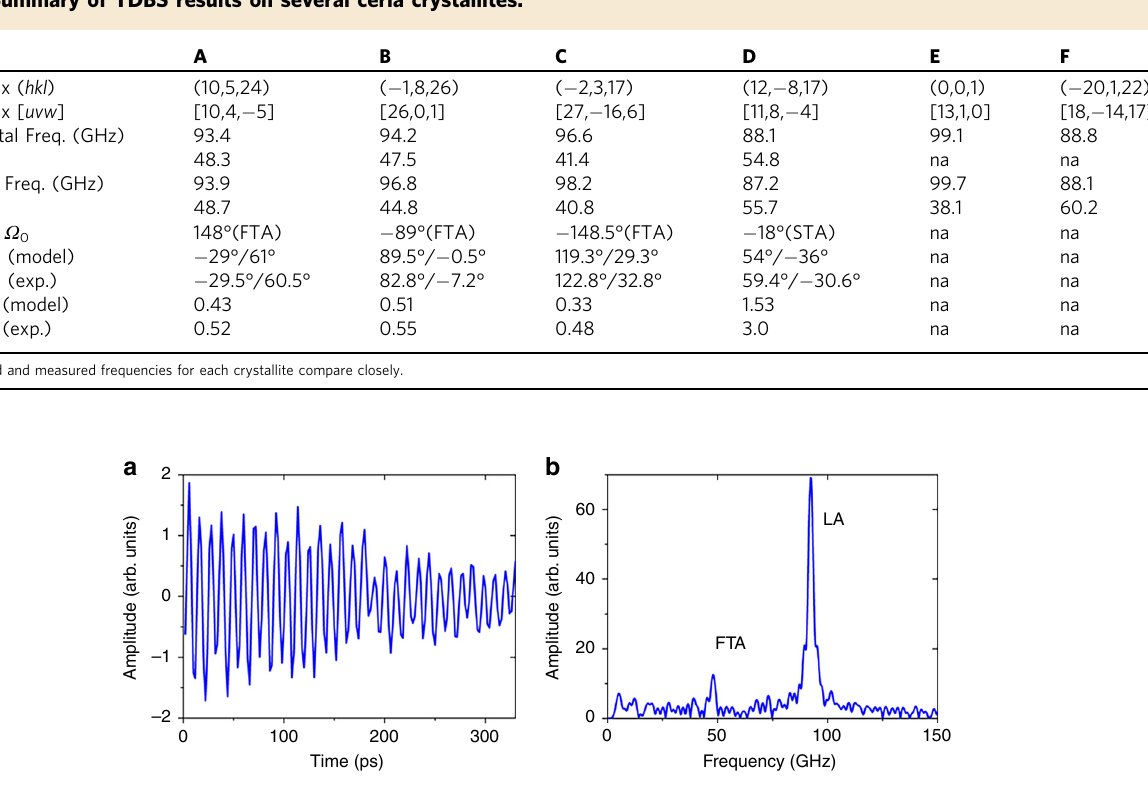
Fig. 2 Transverse and longitudinal acoustic phonons propagating in Grain A. a A time domain trace of Brillouin oscillations corresponding to crystallite A. b Fourier amplitude spectrum of signal. Two peaks are located at 93.4 and 48.3